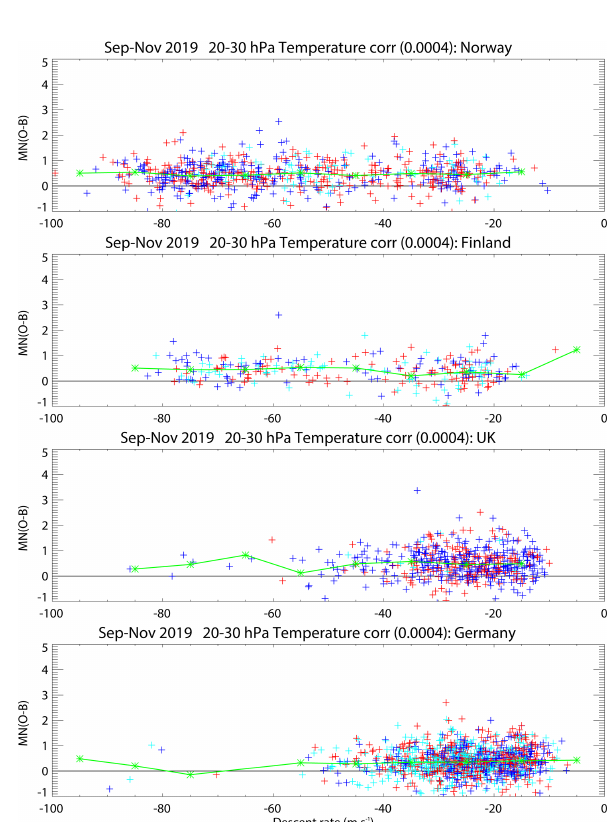
Figure 19. Comparison between the mean fall speed from 20 to 30hPa and the mean O − B temperature after correction using A = 0 . 0004 (cf. Fig. 14). Green markers show the values averaged over all times of the day in bins of 10ms − 1